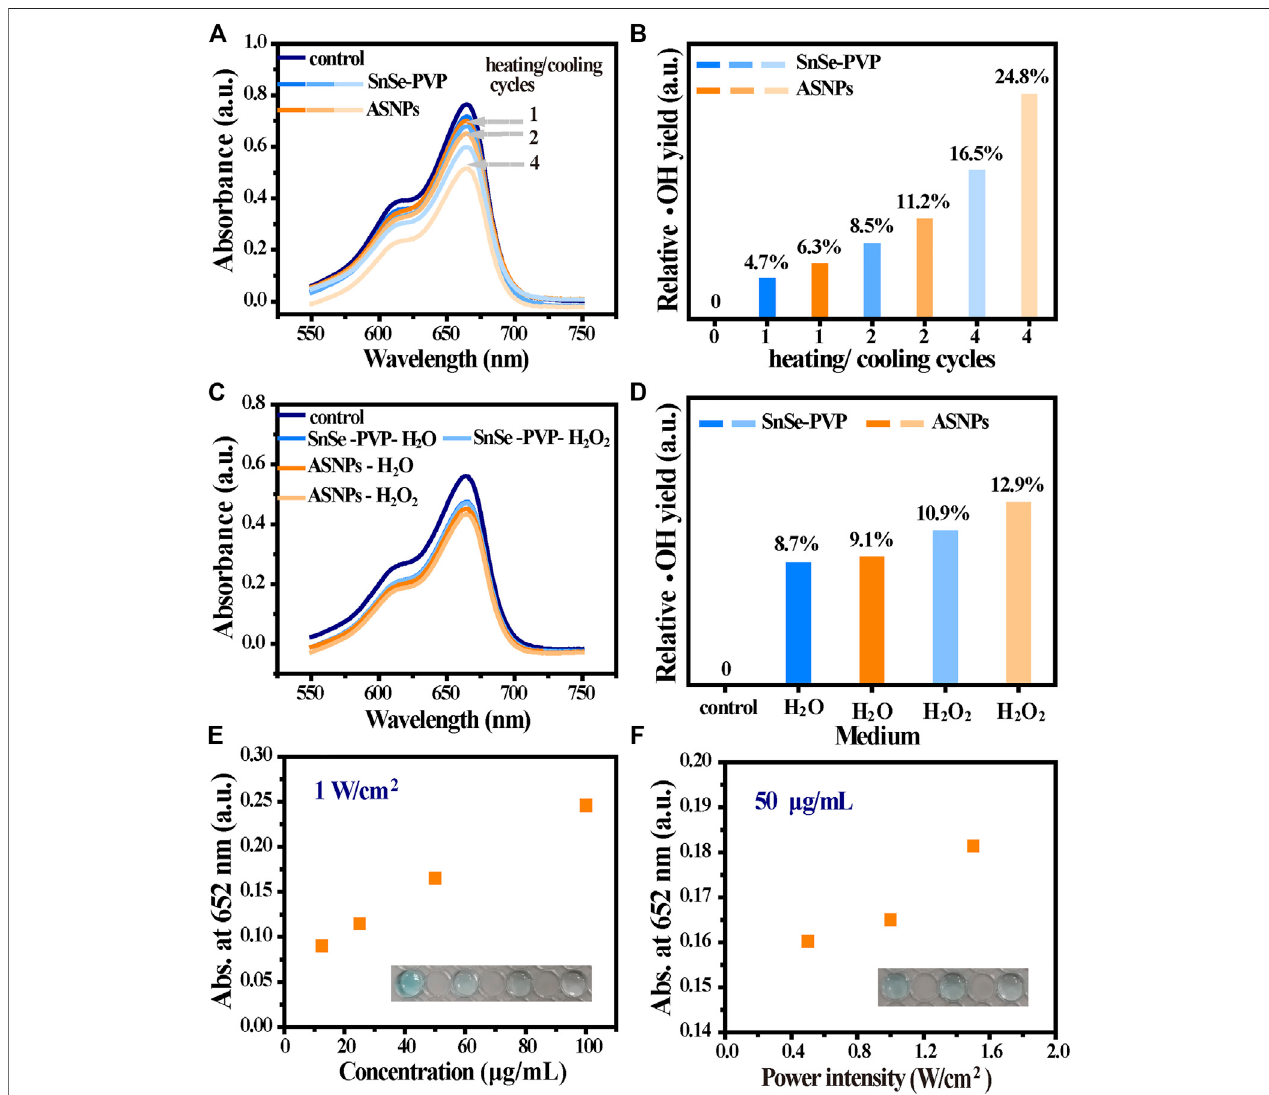
FIGURE 4 | · OH generation performance in the PEDT process. (A) MB degradation under different heating/cooling cycles (1, 2, and 4 times) for SnSe – PVP and ASNPs solutions (50 μ g/mL) at a power intensity of 1 W/cm 2 and (B) the corresponding relative · OH yield. (C) Effect on MB degradation for dispersed SnSe – PVP and ASNPs in H 2 O and H 2 O 2 (50 μ g/mL) with a power intensity of 1 W/cm 2 for one heating/cooling cycle and (D) the corresponding relative · OH yield. The absorbance change at 652 nm after treating TMB with (E) different concentrations of ASNPs (12.5, 25, 50, and 100 μ g/mL) and (F) laser intensities (0.5, 1, and 1.5 W/cm 2